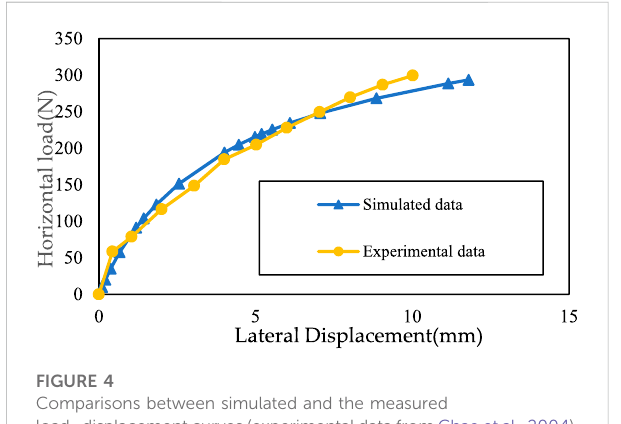
FIGURE 4 Comparisons between simulated and the measured load – displacementcurves (experimental data from Chae etal., 2004).